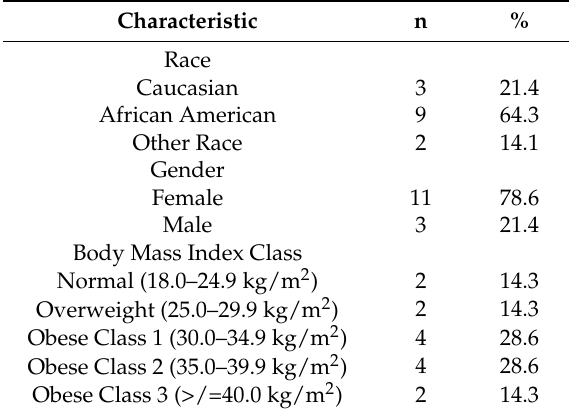
Table 1. Race, gender, and body mass index class of participants, n =